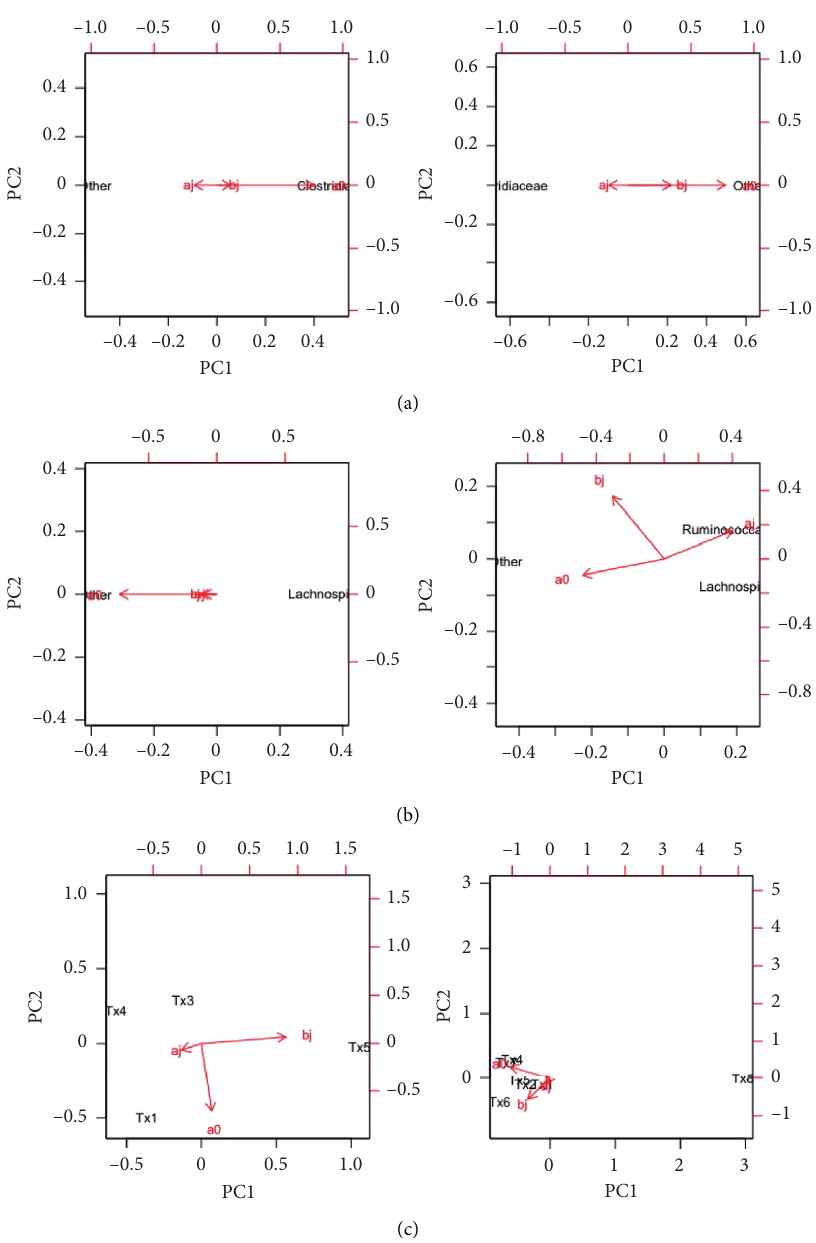
Figure 7: PCA biplot for the subjects reported by Lloyd-Price et al. ((a); (A) and (B)), individuals recorded by Caporaso et al. ((b); (C) and (D)) and simulated datasets ((c); (E) and